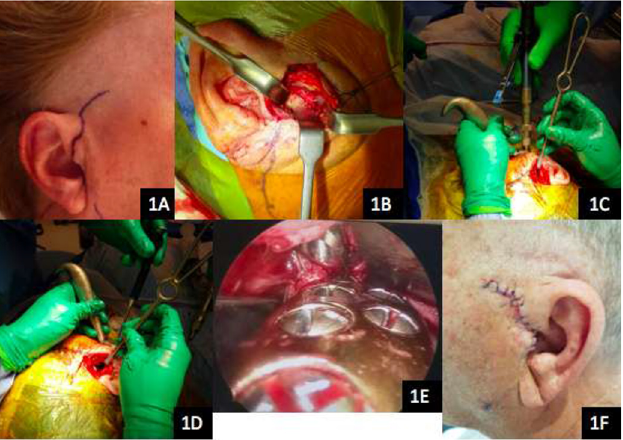
Fig. 1. Total joint replacement via pre-auricular approach with no submandibular incision. (a) The pre-auricular incision with anterior extension is marked out prior to preparation and draping and in fi ltration of local anaesthetic. (b) Dissection through to TMJ as per normal pre-auricular approach. (c) A transbuccal approach is established with a trochar and holes drilled using a drill guide. (d) Fixation of the plate with screws placed through the transbuccal cannula. (e) Visualisation of the prosthesis being fi xated with the use of an angled 4 mm endoscope placed through the pre-auricular incision. (f) Closure of the pre-auricular and transbuccal incisions.